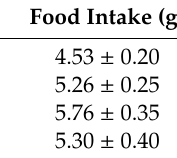
Table 3. Individual daily food intake. The results represent the mean ± SEM of 3 to 4 independent animals. No significant di ff erences between the groups were found by one-way analysis of variance (ANOVA).